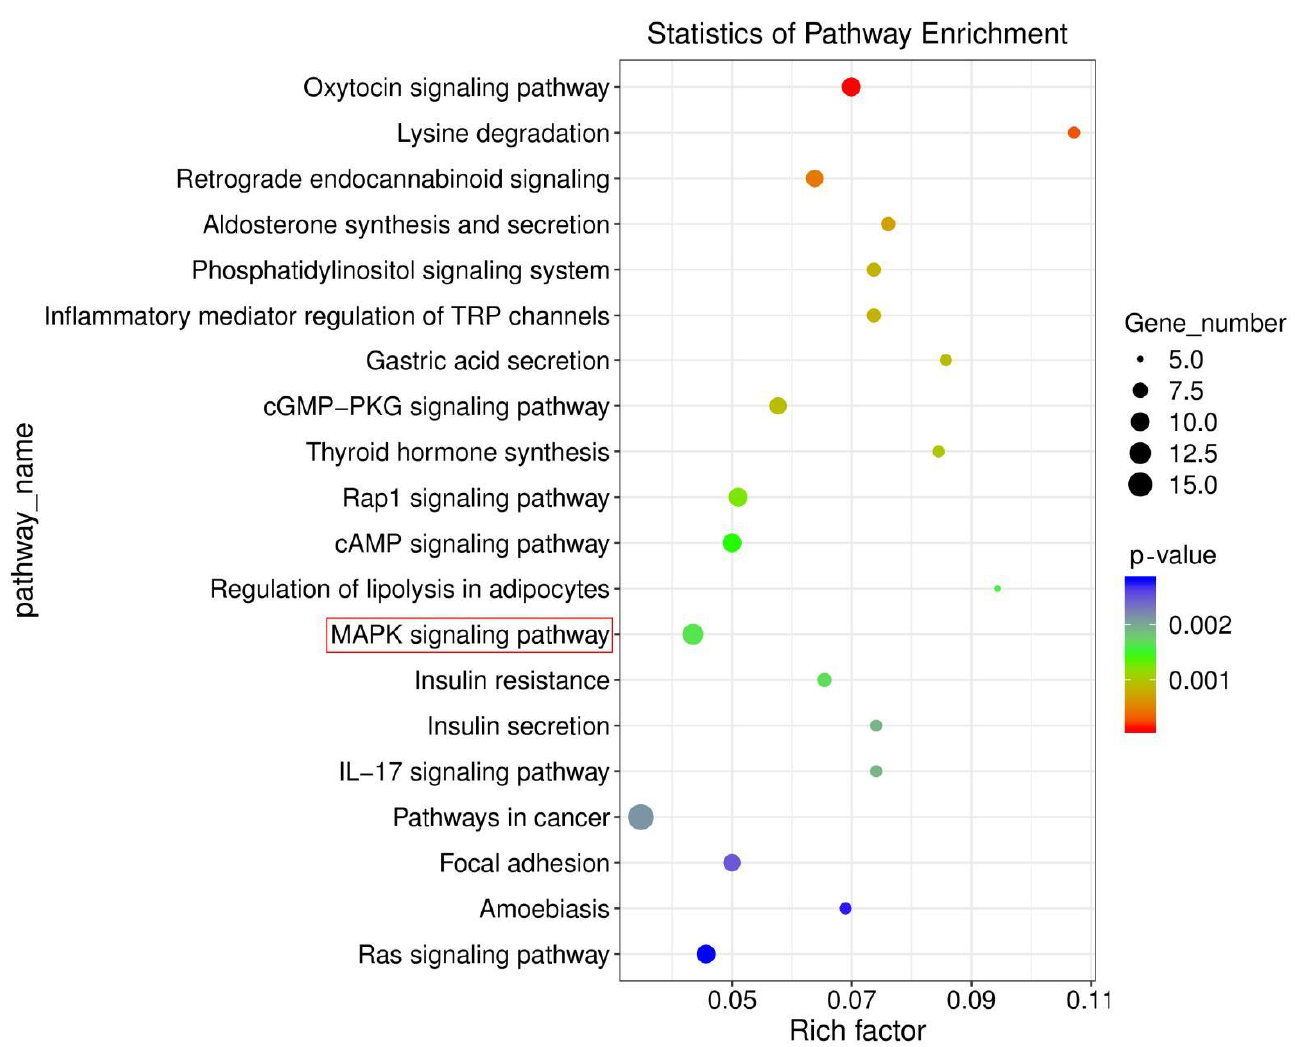
Figure 4. Top 20 pathways showed significant changes in histone methylation-related genes. MAPK signaling pathway was highlighted in red circles.